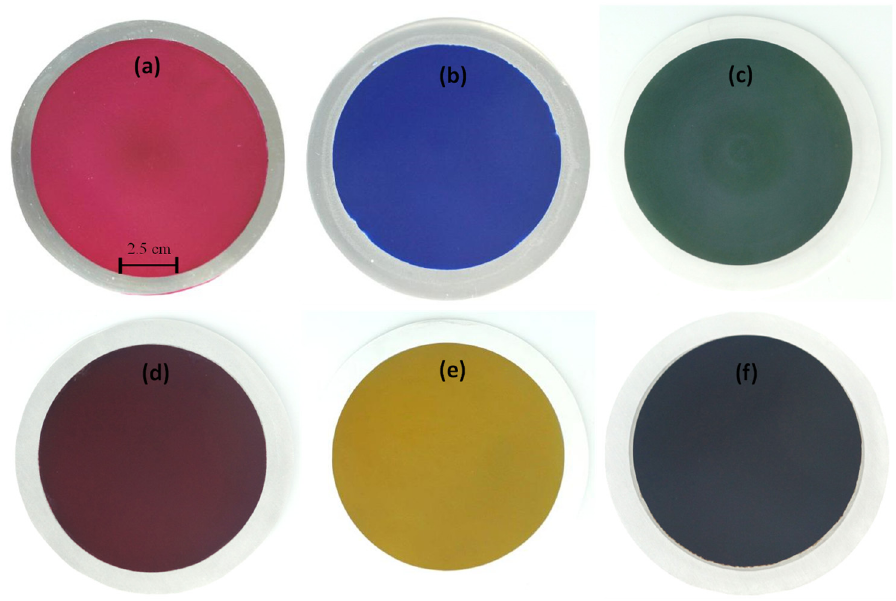
Figure 4. Optical images of thermal spray Al on AISI 1045 after mild anodization and dyed with color: ( a ) red, and ( b ) blue, ( c ) green, ( d ) brown, ( e ) yellow, and ( f ) black.